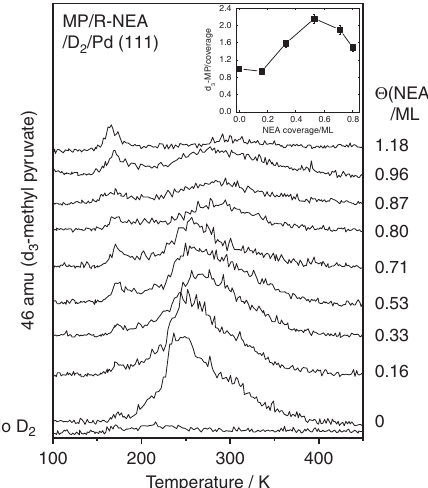
Figure 2 | TPD profiles showing the effect of NEA co-adsorption on hydrogen/deuterium exchange on Pd(111). The traces show the 46 AMU (d 3 -MP) TPD profiles collected following the adsorption of 3L of MP on a Pd(111) surface precovered with NEA and saturated with hydrogen, all dosed at a sample temperature of B 90K, as a function of NEA coverage. The NEA coverages are measured by CO site blocking and the values are displayed adjacent to the corresponding desorption